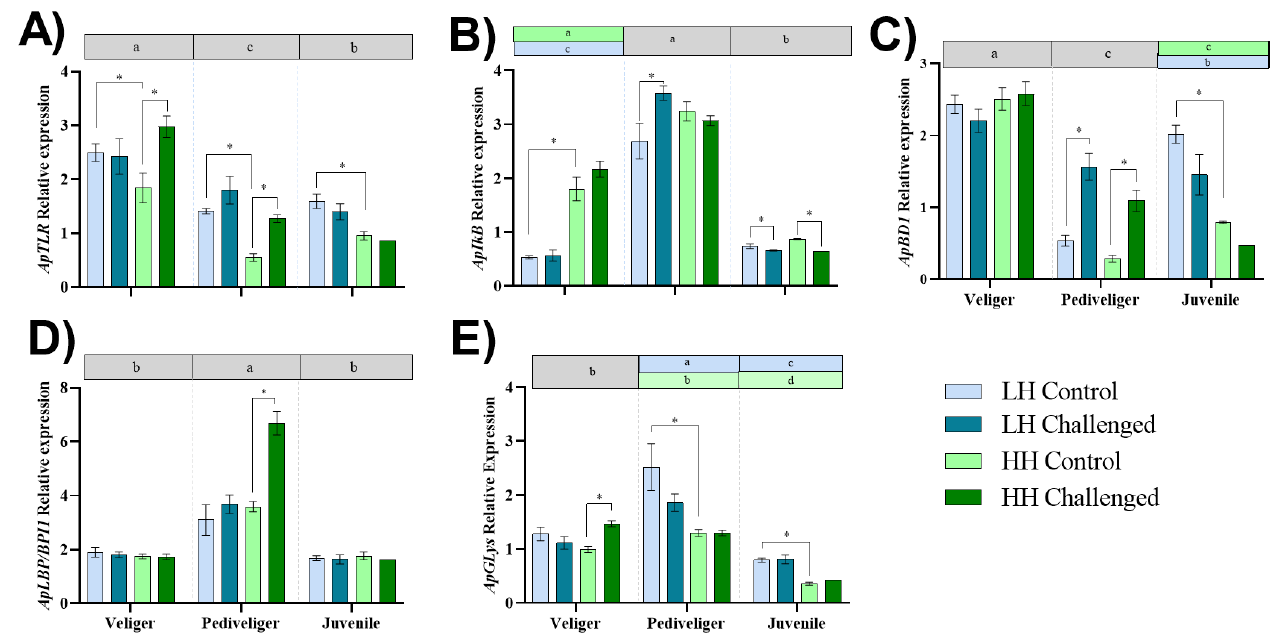
Figure 4. Effect of diets with low (LH) and high (HH) HUFAs on the expression of immune-related genes in larvae and juveniles of the scallop Argopecten purpuratus under unchallenged and Vibrio splendidus (VPA18)-challenged conditions. ( A ) Toll-like receptor ( ApTLR ), ( B ) inhibitor of NF-kB ( ApIkB ), ( C ) big defensin antimicrobial peptide ( ApBD1 ), ( D ) LPS-binding/bacterial permanently increasing protein ( ApLBP/BPI1 ), and ( E ) G-type lysozyme ( ApGLys ). Different lowercase letters show significant differences among developmental stages (gray bars) or diet (blue/green bars) ( p < 0.05). Asterisks (*) indicate significant differences between treatments within each developmental stage ( p < 0.05); n = 6 pools per condition .